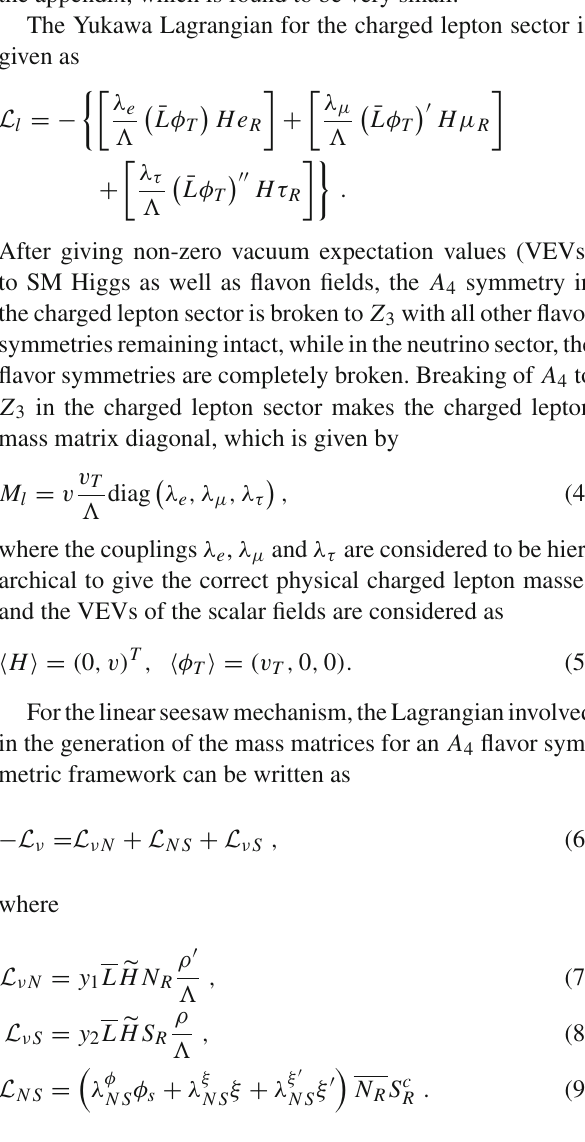
Table 2 Vacuum expectation values of various fields